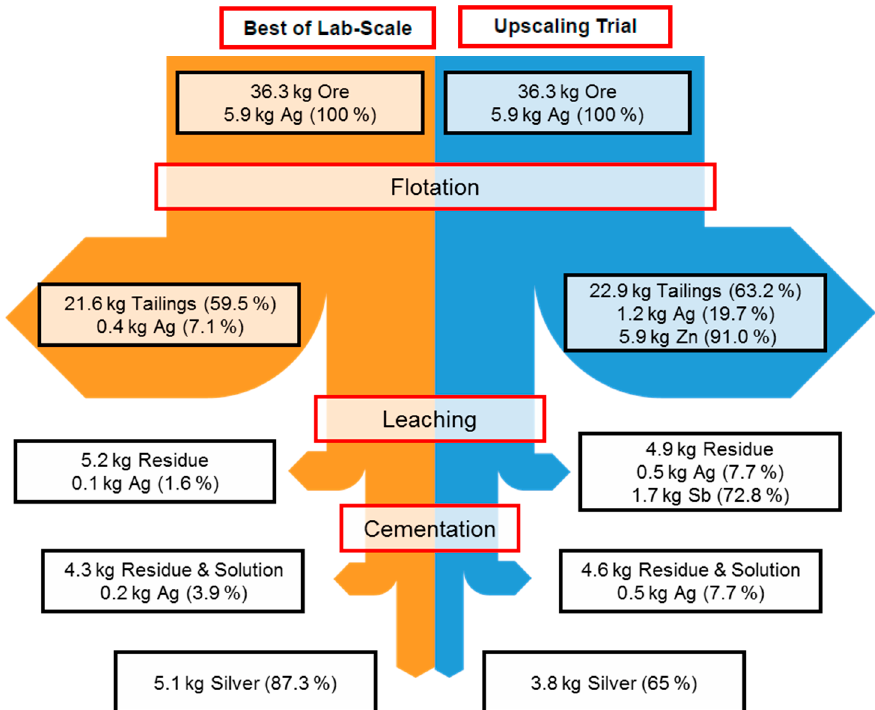
Figure 16. Mass flow diagram comparing best results of lab scale experiments (left) with the upscaling trial (right).